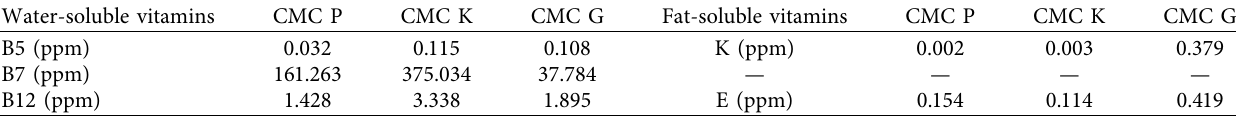
Table 3: Fat-soluble and water-soluble vitamins of cheese with different enzymatic extracts. Water-soluble vitamins